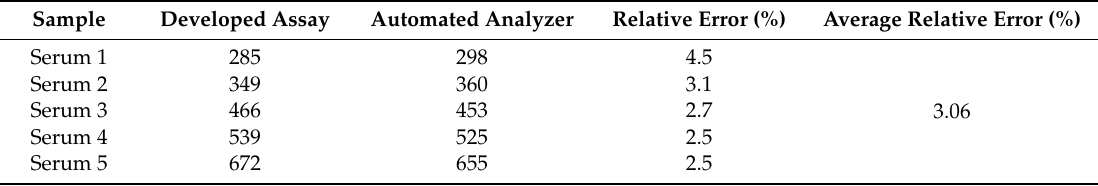
Table 5. Determination of UA in lyophilized human serum using the developed assay and a clinical chemistry